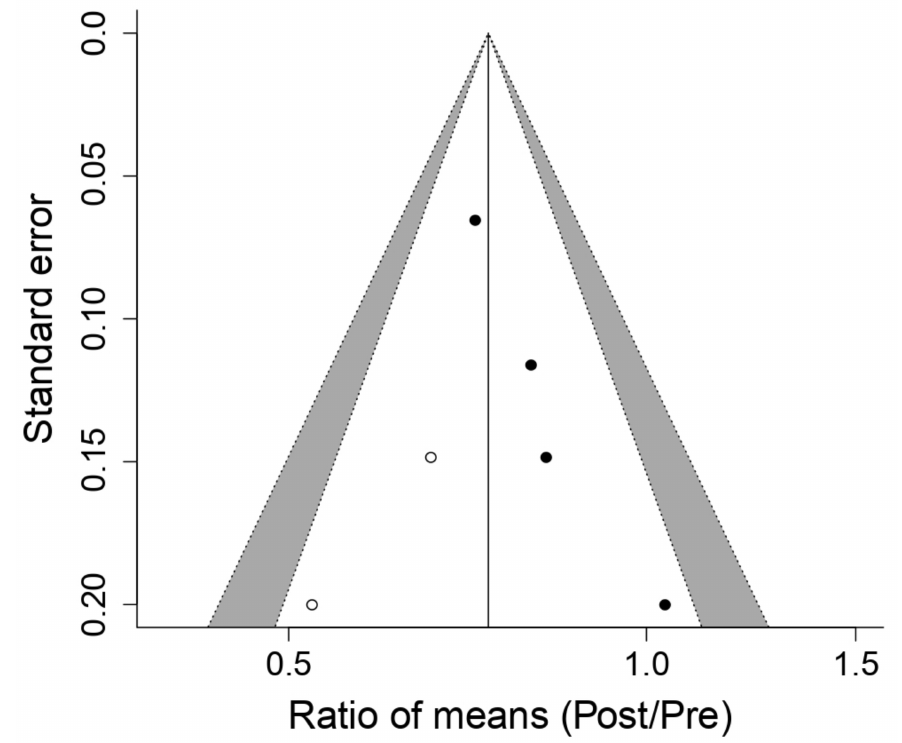
Figure 7. Funnel plot of the meta-analysis of the effects of inspiratory muscle training with PowerBreath ® on blood lactate concentration. Pre: Pre-inspiratory muscle training; Post: Post-inspiratory muscle